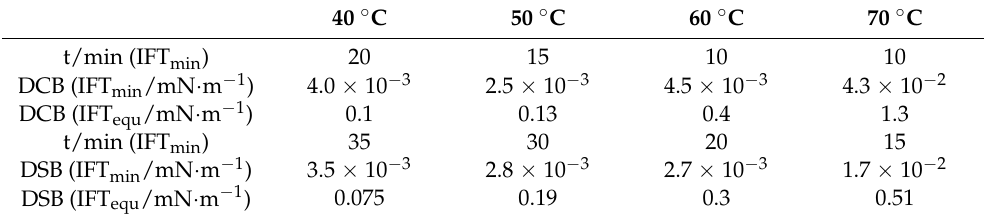
Table 1. Parameters on the lowest interfacial tension (IFT min ) and the equilibrium interfacial tension value (IFT equ ) of the required time vary with temperature.